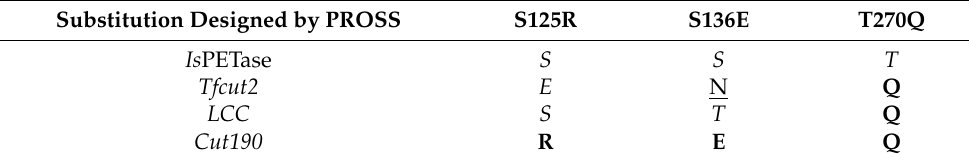
Table 1. Alignment of mutations suggested by the PROSS server and confirmed by simulation, with the three thermostable PET hydrolases Tfcut2, LCC, and Cut190. Three of the mutations showed matches with the thermostable PET hydrolases and were experimentally produced and assessed for their thermostability and PET hydrolytic activity. Bold-labelled amino acids show agreements with the substitution suggested by PROSS; underlines are similar amino acids to those suggested by PROSS, while those that are italic are substitutions for an amino acid with a side chain of significantly different